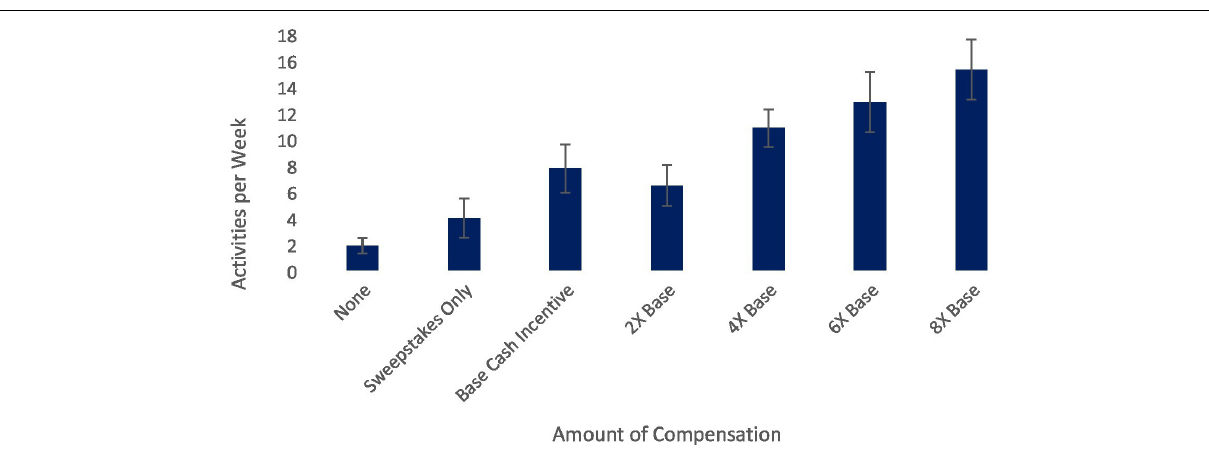
FIGURE 2 | Relationship between cash incentive level and activities completed per week on a digital mental health